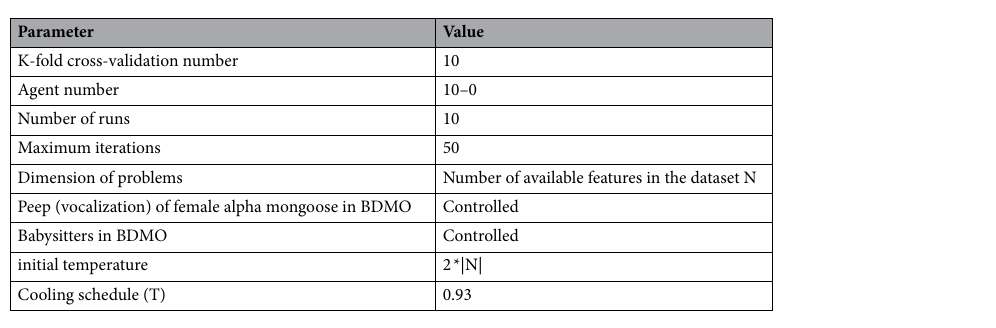
Table 2. Experimental parameter